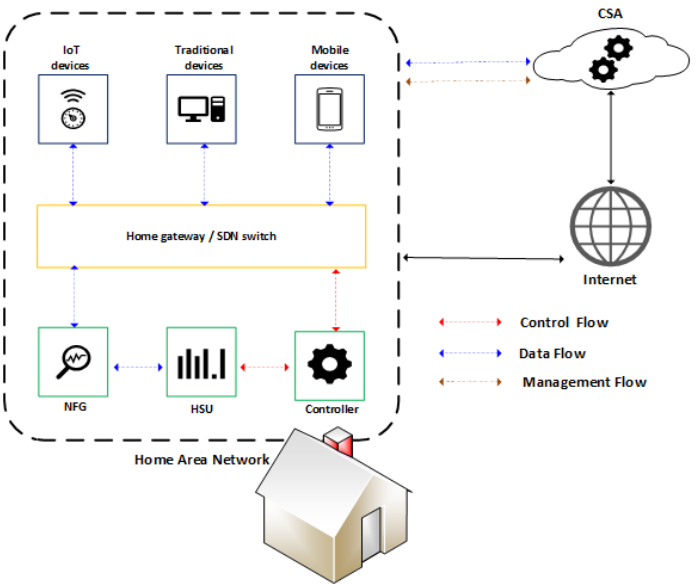
Figure 2. Communication between the architecture